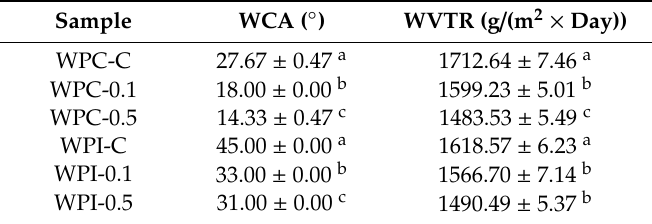
Table 5. Water Contact Angle (WCA) and Water Vapor Transmission Ratio (WVTR) of neat WPC / WPI and melanin-modified